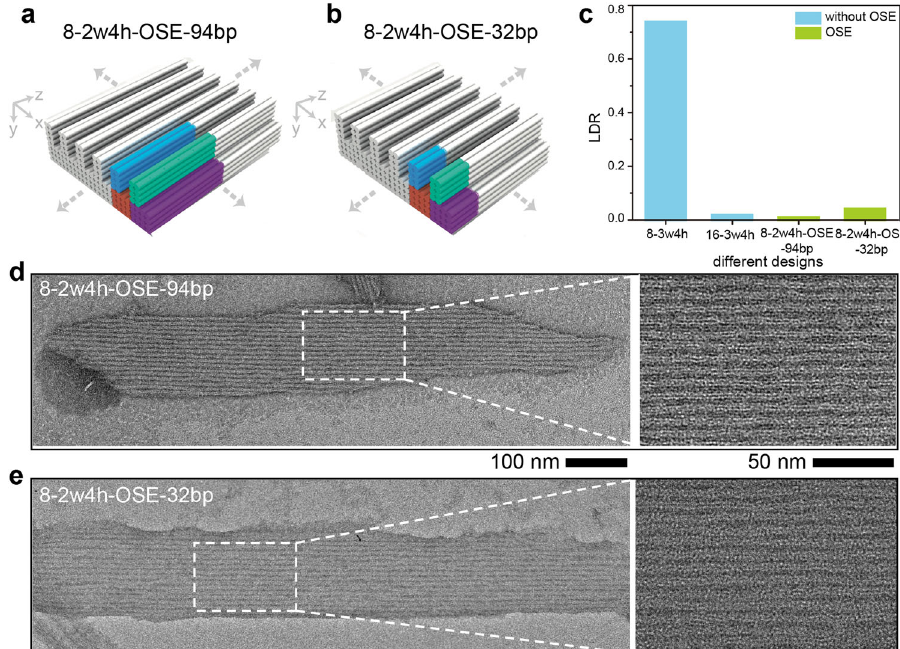
Fig. 5 OSE approach to suppress crystallographic defects. Design schematic ( a and b ), zoomed-out ( d and e , left) and zoomed-in ( d and e , right) TEM images for the representative DNA line arrays of 8-2w4h-OSE-94bp ( a and d ) and 8-2w4h-OSE-32bp ( b and e ), where 94 bp and 32 bp denote the basepairs along z direction within the unit cell. The colored bundles in a and b indicate the two neighboring unit cells assigned with the orthogonal sequences. The scale bars are 100 nm ( d and e , left) and 50 nm ( d and e , right). c LDR values for different DNA line arrays designed with and without OSE approach (8-3w4h, 16-3w4h, 8-2w4h-OSE-94bp, and